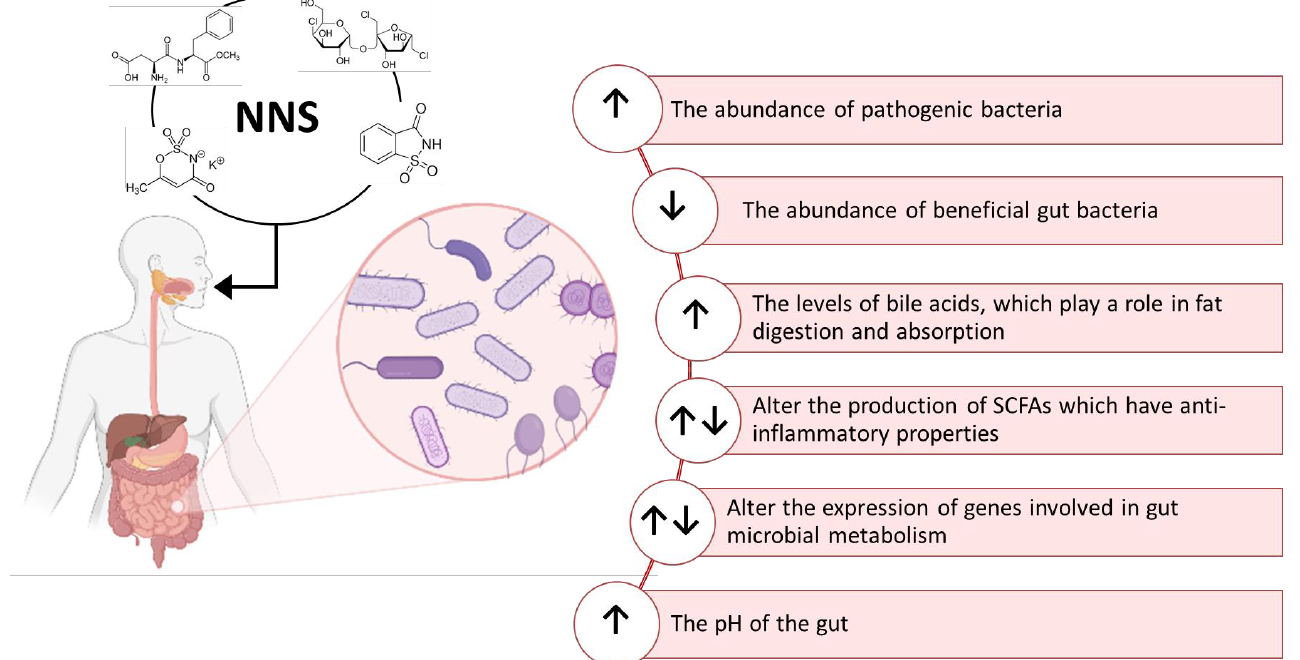
Figure 4. Overview of some of the documented effects of NNS in both humans and the gut micro- metabolism. Created with biota metabolism. Created with BioRender.com.